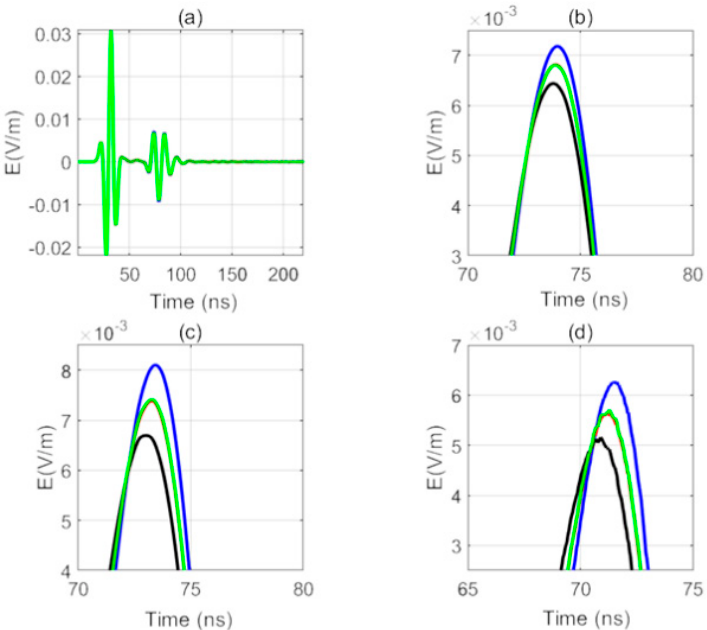
Figure 12. Received signals for sondes with different diameters (blue: the east antenna; black: the west antenna; red: the south antenna, green: the north antenna). ( a ) Received signals for a sonde diameter of 3 cm, ( b ) local amplification for ( a ), ( c ) local amplification for a sonde diameter of 5 cm, and ( d ) local amplification for a sonde diameter of 7 cm.